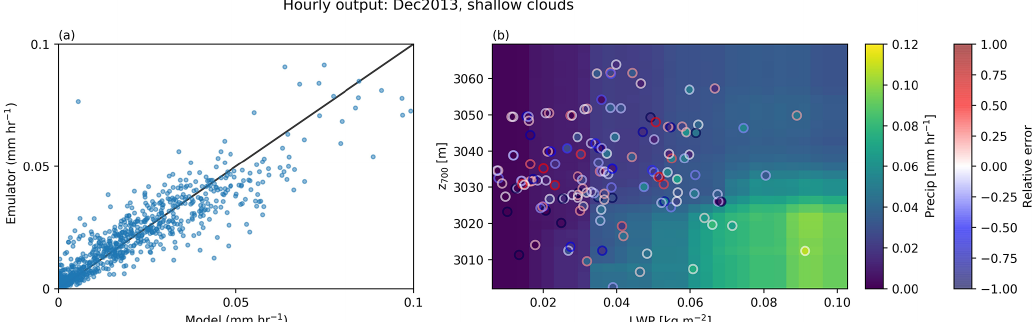
Figure 4. The mean precipitation emulated by ESEm using a random forest model trained on the five environmental factors diagnosed from an ensemble of cloud-resolving models as described in the text. Panel (a) shows a validation plot of the emulated precipitation values against the model values using leave-one-out cross-validation. Panel (b) shows the emulated precipitation plotted as a function of liquid water path and geopotential height at 700hPa ( z 700 ) by averaging over the remaining three dimensions corresponding to SST, EIS and w 700 . A random subset of 140 of the training points are also shown overlaid on the emulated precipitation as scatter points, with the scatter outlines showing the relative error between the emulator and the training data.